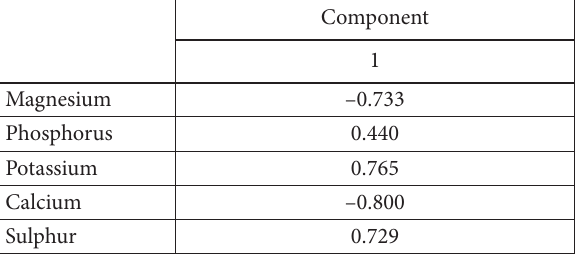
Table 6b. Rotated component matrix for macro-nutrient